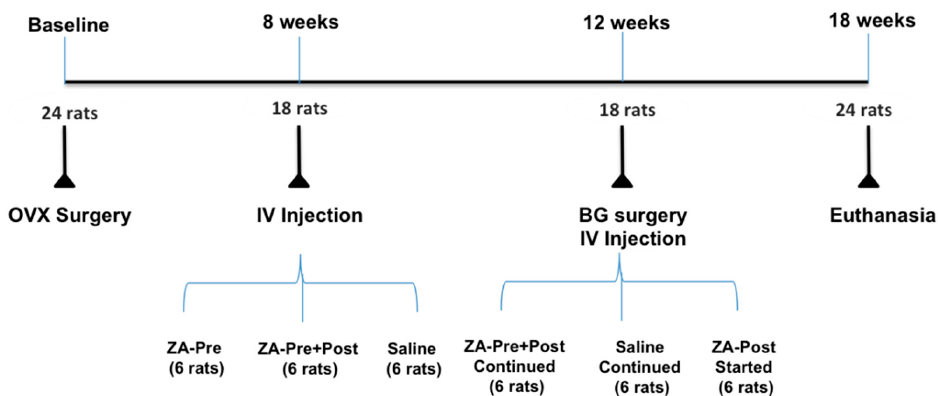
Figure 1. Experimental animal groups and timeline of intravenous injections, surgical procedures, and euthanasia. OVX; ovariectomized, IV, intravenous, BG, bone graft, ZA, zoledronic acid. Zoledronic acid injection (0.04 mg/kg body weight) (Zometa 4 mg/5 ml,